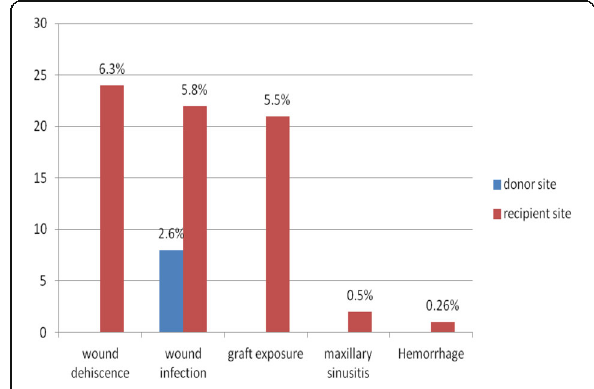
Fig. 1 Postoperative complications at the donor and recipient site,